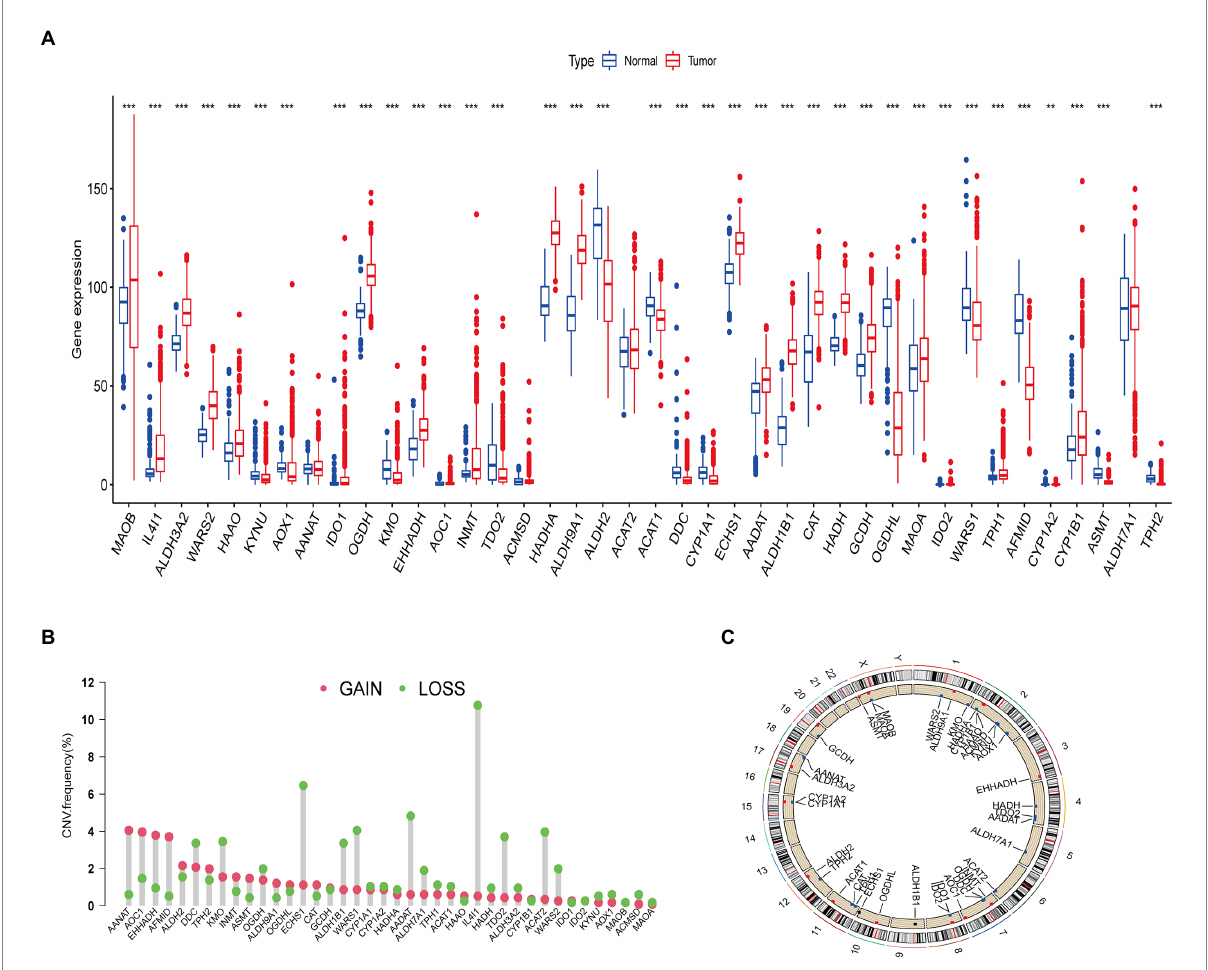
FIGURE 1 Genetic and transcriptional alterations in tryptophan metabolic genes in glioma. (A) Expression distributions of 40 tryptophan metabolic genes in normal vs. glioma tissues. (B) Frequencies of copy number variations (CNVs) including gain and loss, and non-CNV genetic variants among tryptophan metabolic genes. (C) Locations of CNVs in tryptophan metabolic genes across the 23 human chromosomes. * p < 0.05, ** p < 0.01, *** p <